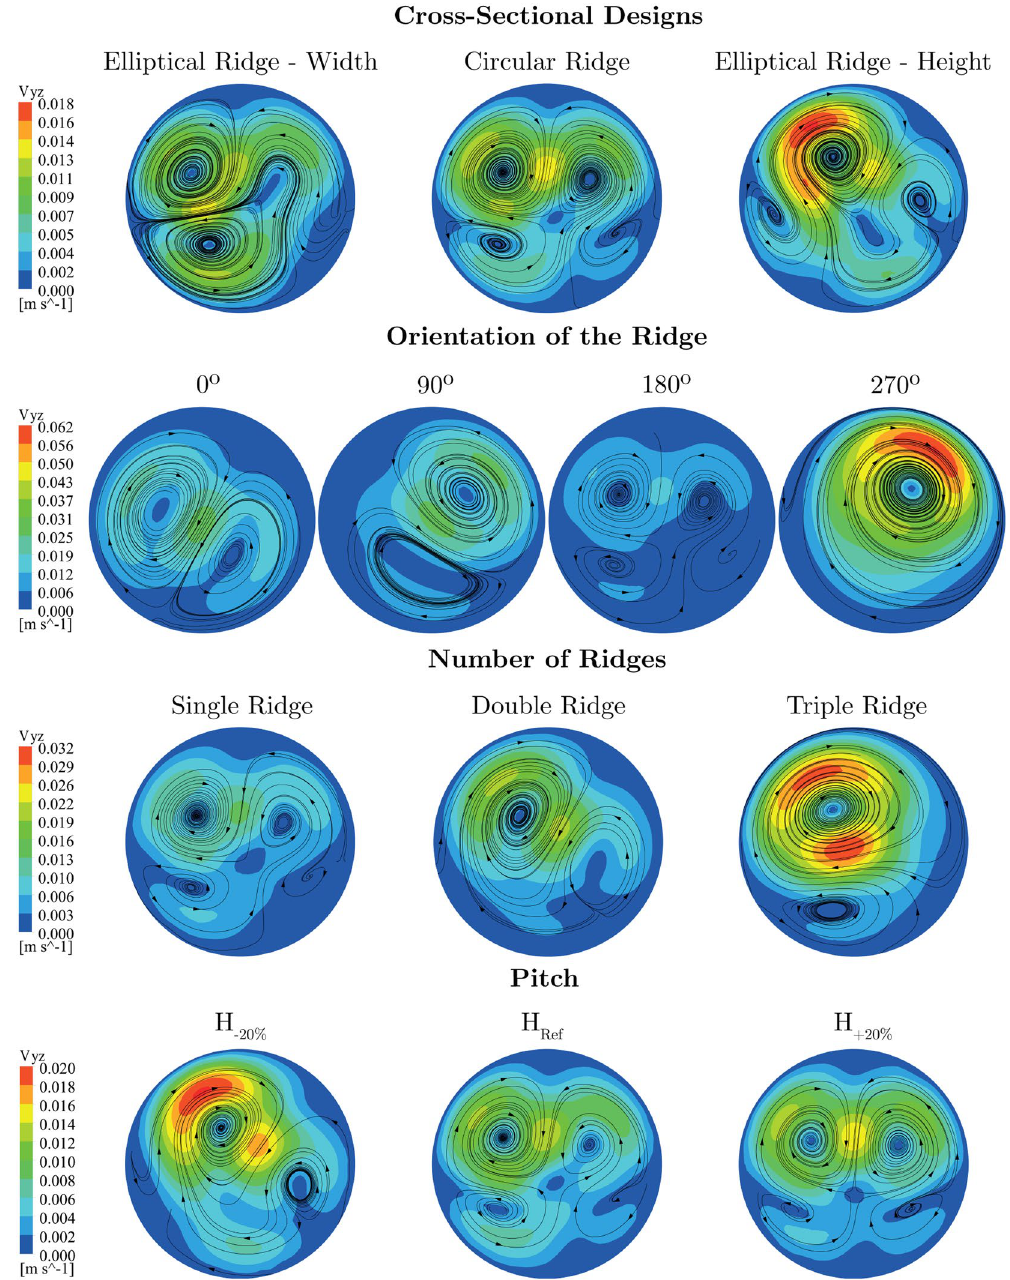
Figure 2. Contours of secondary velocity and crossflow streamlines for different ridge designs at monitoring plane